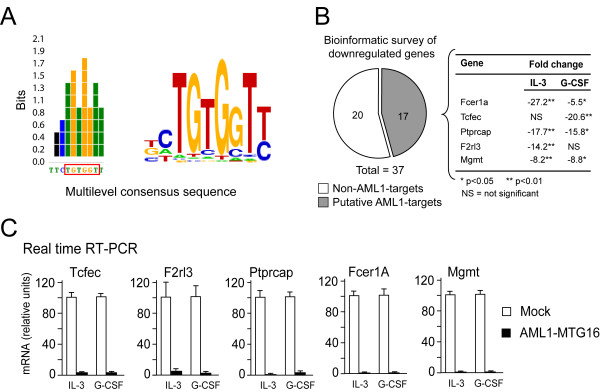
AML1-MTG16-induced downregulation of putative AML1-targets. A. The AML1-consensus motif, containing the AML1-consensus sequence (framed), found by bioinformatic analysis of the genes significantly downregulated in A16 cells. The height of the columns associated with each nucleotide is proportional to the conservation level. The "logo" representation of the motif instead indicates in which proportion the single bases are present at each position. B. Seventeen out of the 37 downregulated genes are putative AML1-targets. The fold-changes of five of the most significantly downregulated genes are reported at right. C. Real time RT-PCR confirmed the significant (p < 0.01) downregulation of the five genes.